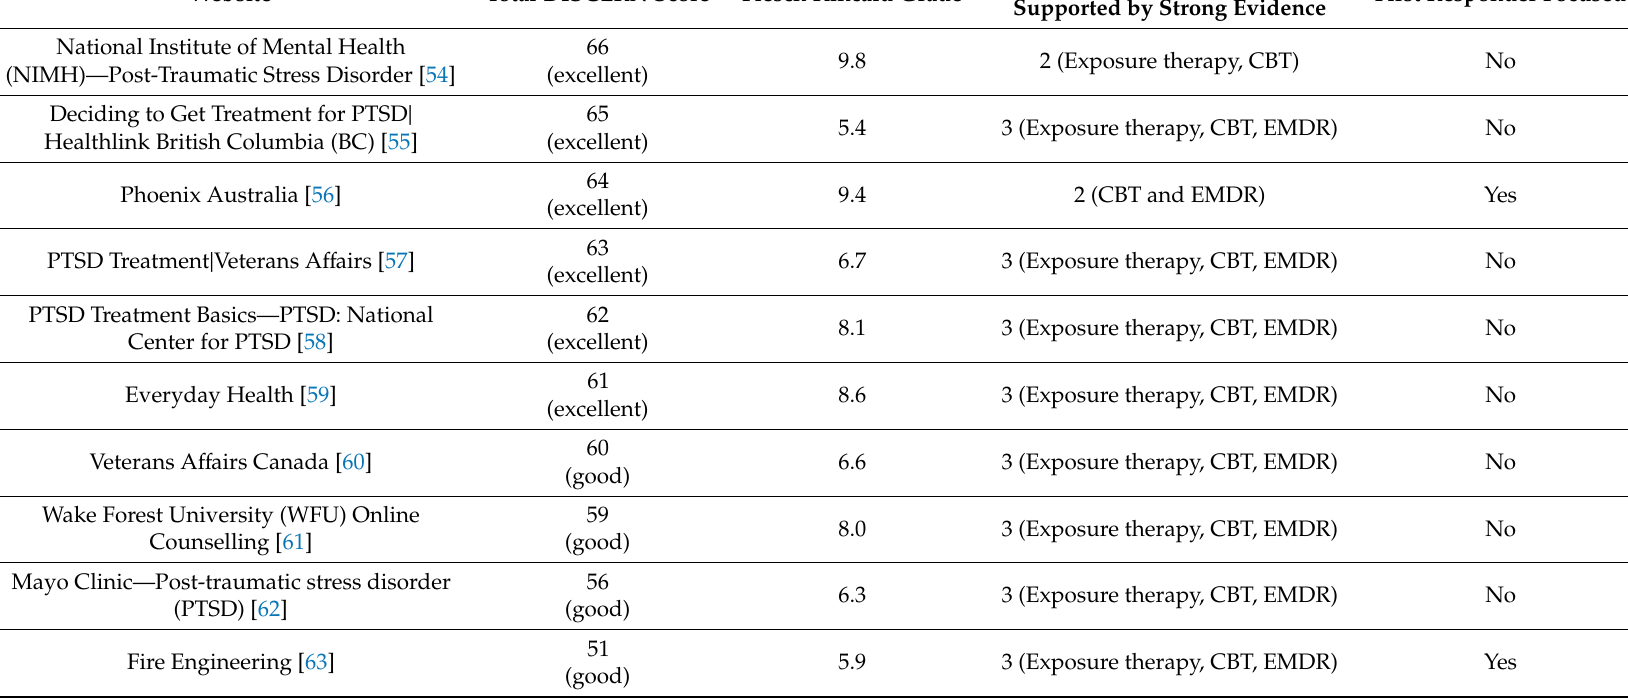
Table 3. The 10 best websites based on the total DISCERN score and rating category, the Flesch–Kincaid Grade, and the number of treatments the websites mentioned that have been supported by strong evidence. The average DISCERN total scores are out of a total possible score of 75, with higher scores representing better quality websites. The average Flesch–Kincaid Grade levels represent school grade levels, with lower grades being simpler to read and understand. There is a total of three treatments supported by strong evidence (i.e., exposure therapy, CBT, and EMDR). The category ‘First Responder Focused’ refers to whether or not the website is targeted towards first responders (including